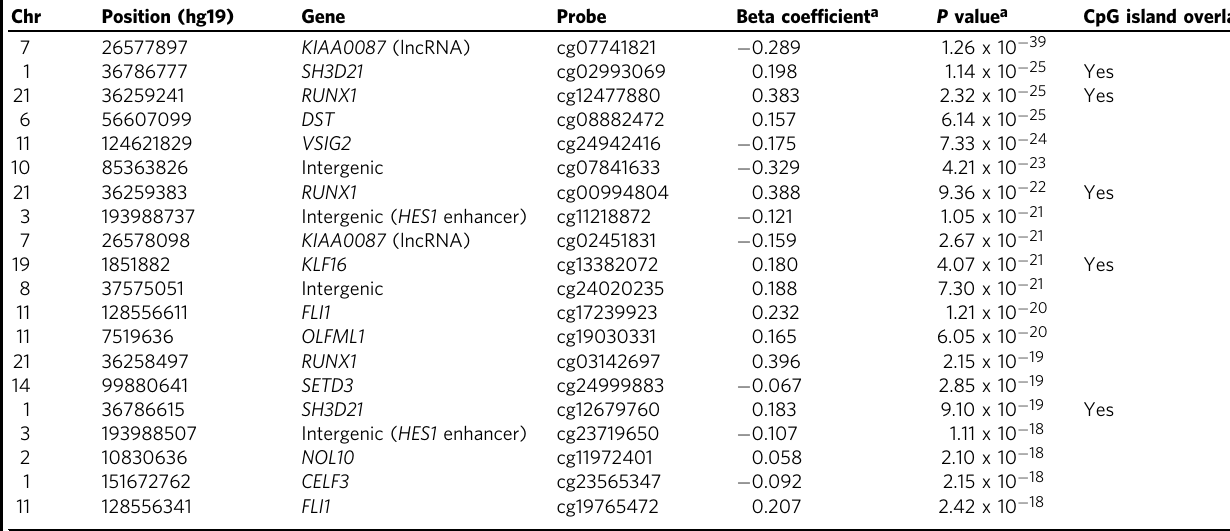
Table 2 Top differentially methylated CpG probes associated with Down